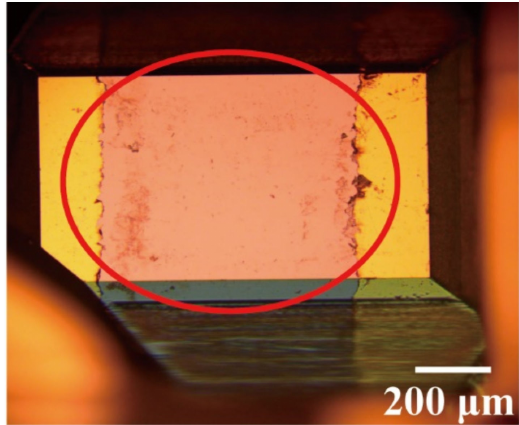
Figure 2. Device pictures of NbAs